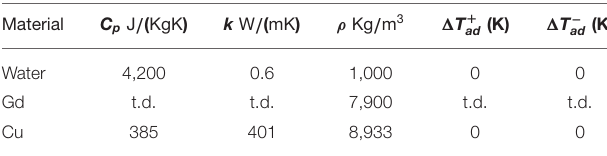
TABLE 1 | Physical properties of the used materials in the modeled system (mat, 2019).